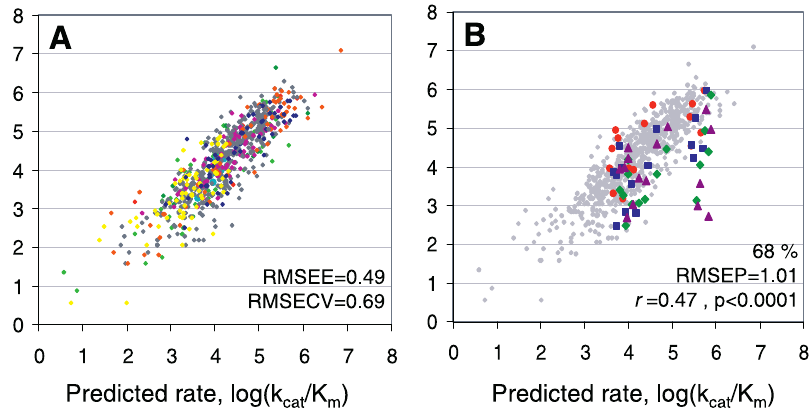
Figure 1. Goodness of Fit and Experimental Validation for the CRM (A) Observed versus predicted rate of cleavage of 299 substrates by 61 retroviral proteases (in total, 760 protease–substrate combinations) for the CRM, in which all predictions relate to model-building data (R 2 ¼ 0.77; Q 2 ¼ 0.52). Each bullet represents naturally occurring and artificially mutated protease forms of HIV-1 (gray), HIV-2 (magenta), AMV (light green), RSV (blue), HTLV-1 (orange), BLV (red), Mo-MuLV (yellow), EIAV (green), and FIV (light blue). (B) A priori prediction of cleavage rates of 15 novel peptides with diverse structures by the CRM (Table 3, numbers 4–18). Shown is the predicted versus experimentally determined cleavage rates by HXB2 (red) and mutant HIV-1 proteases, I84V (blue), L90M (magenta), and I84 þ L90M (green). The prediction error for the cleavage rates was less than one log(k cat /K m ) unit for 68% of the protease–substrate pairs; the correlation for the a priori predicted rates versus the experimentally determined rates yielding a correlation coefficient r ¼ 0.47 ( p , 0.0001), as indicated on the panel. The data in (A) is also shown in (B) (gray).